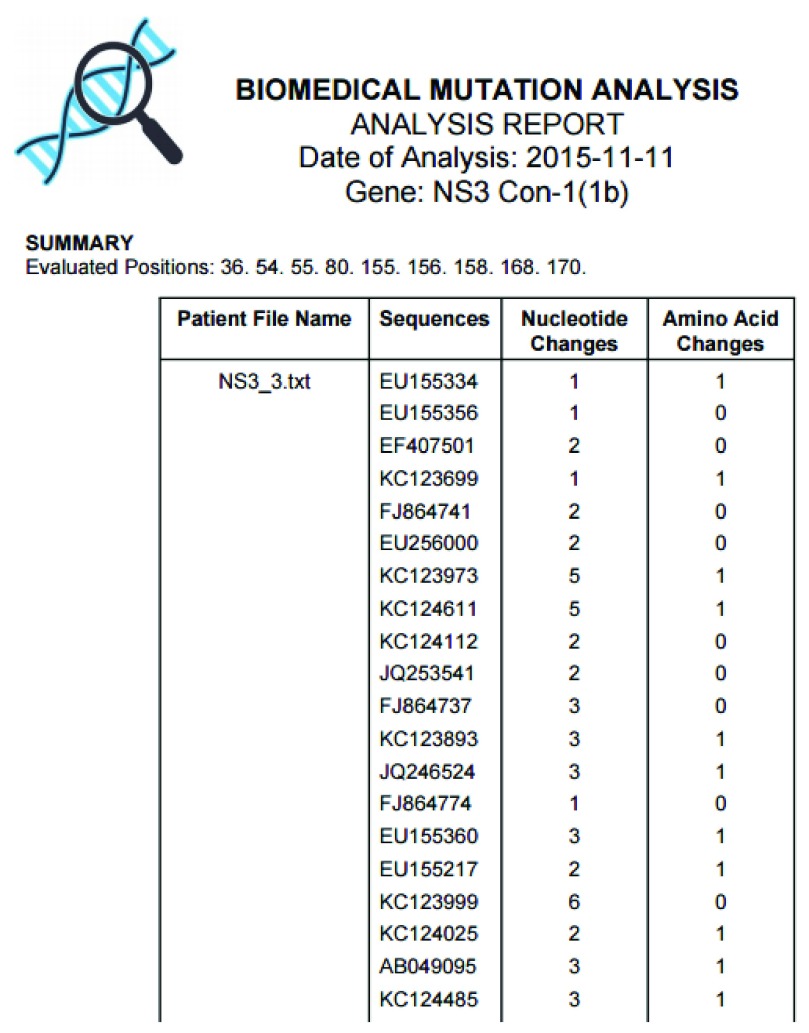
Analysis report.